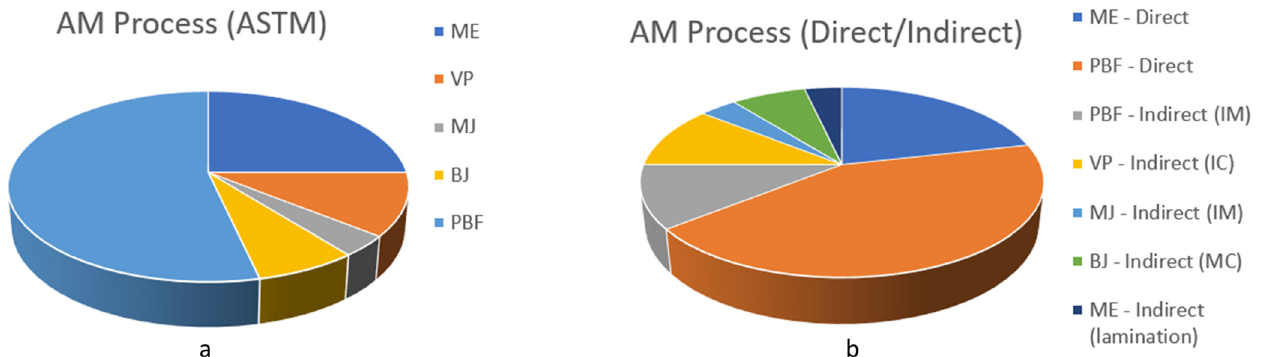
Figure 11. Use of AM in spare-part reconstruction cases, respectively, in accordance with ( a ) the ASTM categories and ( b ) the direct/indirect processes (source: authors’ elaboration based on the literature review).